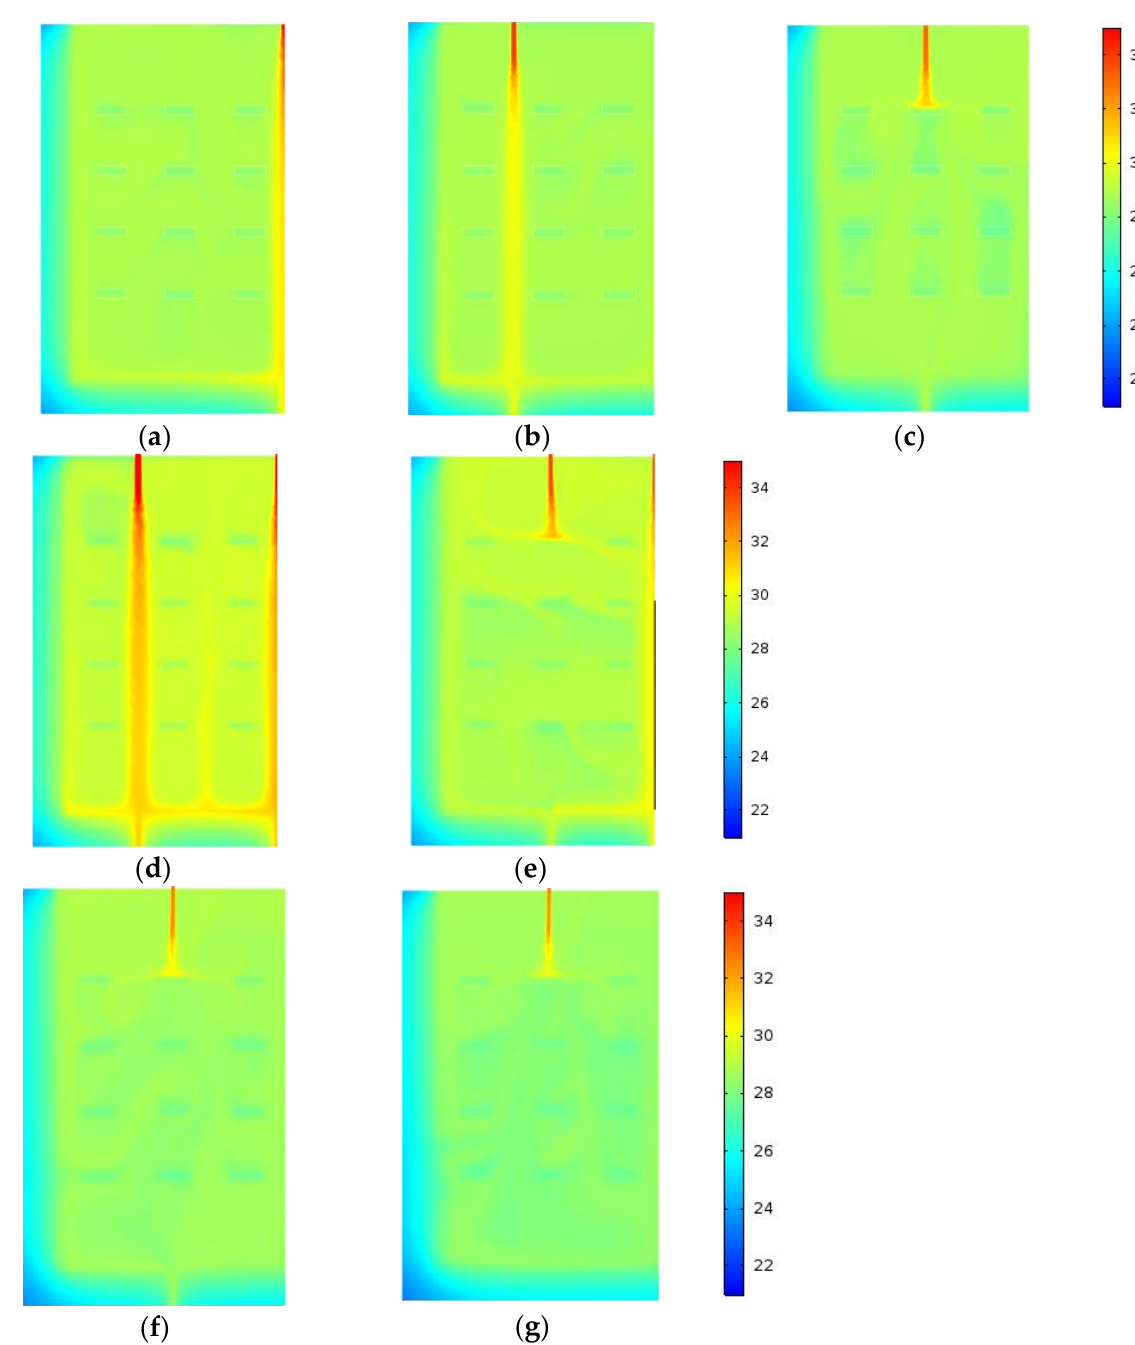
Figure 23. Temperature cloud of the reservoir at 20 h under different water distribution modes: ( a ) one-inlet–one-outlet; ( b ) two-inlets–two-outlets-a; ( c ) two-inlets–two-outlets; ( d ) three-inlets–three-outlets-a; ( e ) three-inlets–three-outlets-b; ( f ) four-inlets–four-outlets; and ( g ) four-inlets– one-outlet.